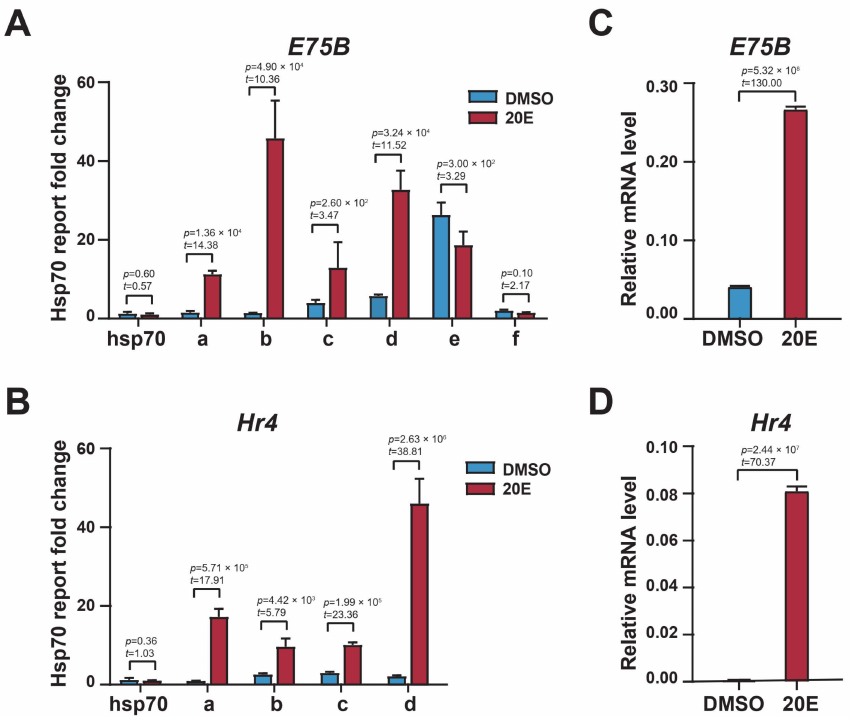
Figure 2. H3K27 acetylation was required for E75B and Hr4 enhancer activity and mRNA expres- sion. ( A , B ) Functional testing of enhancers in DMSO or 20Etreated BmE cells via luciferase assays. Enhancers were cloned using primers designed to amplify the putative regulatory elements of E75B and Hr4 loci. The changes shown were fold increases over the pGL3 reporter backbone with the hsp70 core promoter. ( C , D ) RT–qPCR of E75B and Hr4 expression in DMSO- or 20E-treated BmE cells. We calculated the ratios of the RNA levels of the gene of interest to those of RP49 in DMSO- and 20E-treated cells. Error bars: standard error of the mean (SEM) from three biological replicates measured in duplicate. Student’s t -test (df =